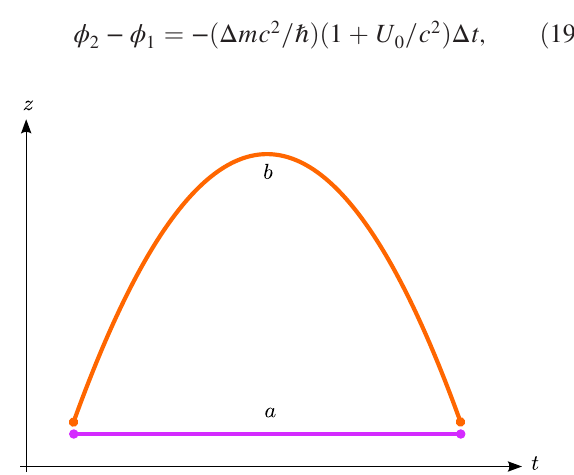
FIG. 2. Spacetime trajectories in a uniform gravitational field for a two-level atom trapped at constant height ( a ) and for a freely falling one ( b ). They correspond to the central trajectories of the atomic wave